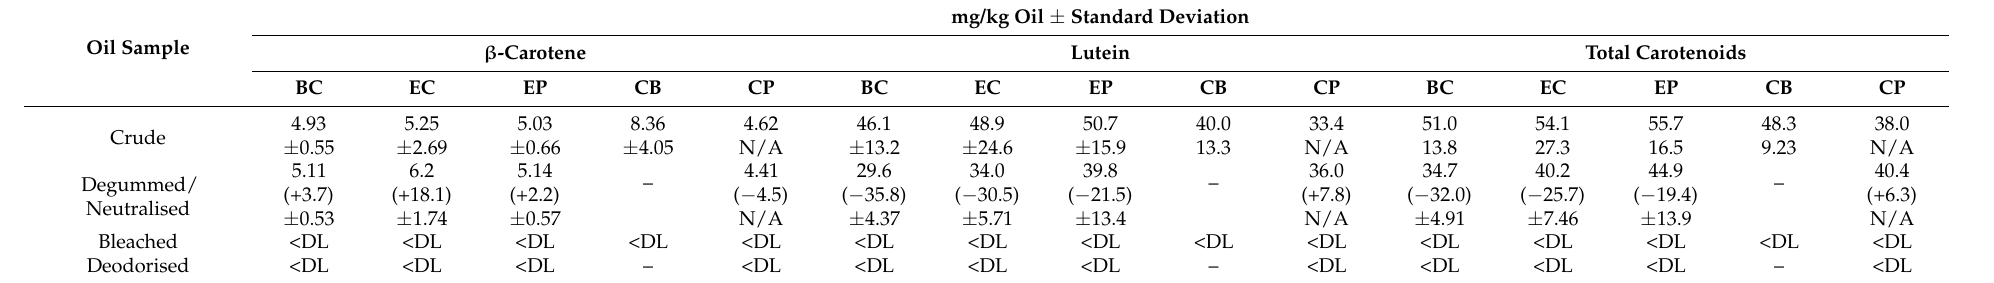
Table 5. Concentration of β -carotene, lutein, and total carotenoids (mg/kg oil ± standard deviation). Percentage gain/loss relative to previous process is represented in brackets under concentrations for refining